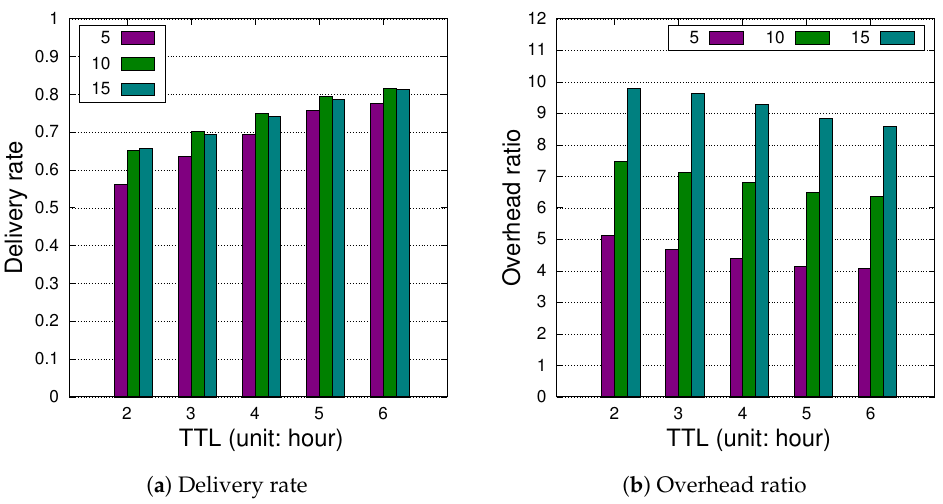
Figure 8. Results by MPMF with different values of L and TTL under NCCU trace (buffer size = 10 MB).